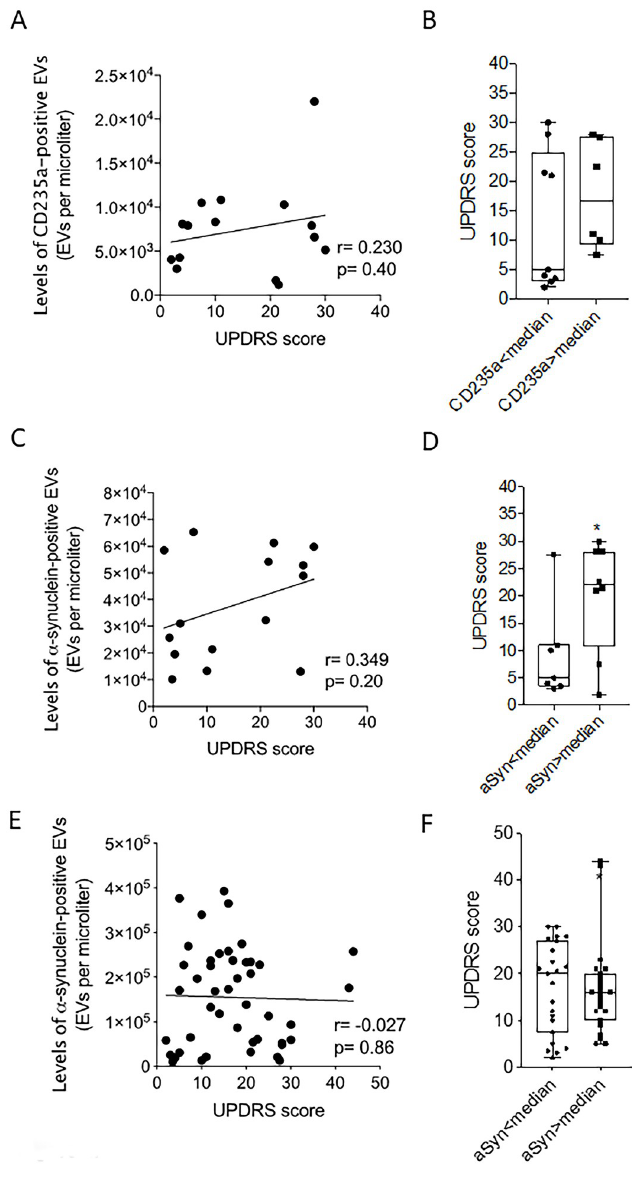
Fig 3. Levels of CD325a-syn EVs in PD and correlation with UPDRS scores. A) Levels of total a-syn EVs in PD and correlation with UPDRS scores; B) UPDRS scores and median levels of CD325a-syn EVs in PD; C) Levels of total a-syn EVs in PD and correlation with UPDRS scores; D) UPDRS scores and median levels of a-syn EVs in PD; E) Levels of total a-syn EVs in PD and correlation with UPDRS scores in replication cohort; F) UPDRS scores and median levels of a-syn EVs in PD in replication